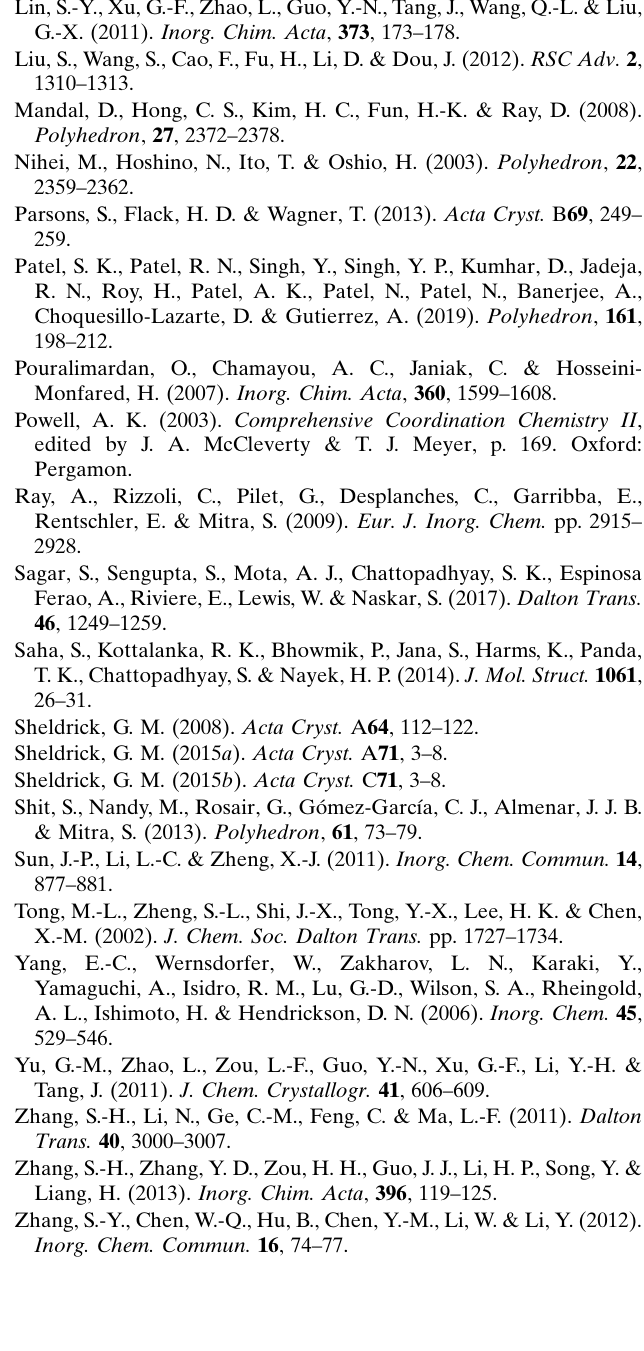
FTIR (KBr, (cid:11) , cm (cid:3) 1 ): 1626 (>C N), 1537 (C—O), 487 (Ni— O) and 421 (Ni—N).